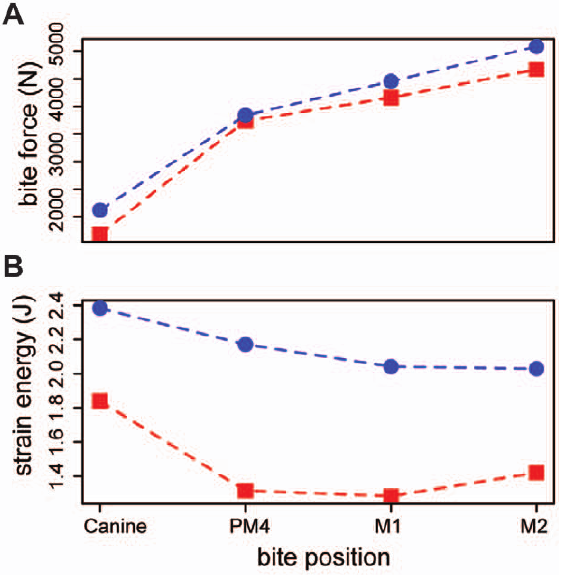
Figure 2. Performance metrics assessed for four different bite positions in the polar bear (blue symbols) and brown bear (red symbols) FE models. The X axis corresponds to bite point, with anterior bites towards the left and posterior bites to the right. Panel A shows bite forces, panel B shows cranial strain energy. Note that bite forces are similar in both species for all bites, while strain energies are uniformly lower in the brown bear.